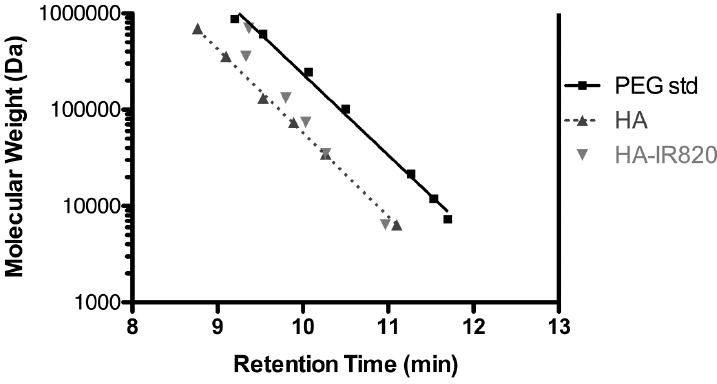
Figure 1. Retention time vs. MW for PEG standards, HA samples, and HA-IR820 conjugates from SEC, using a Shodex OHpak SB-806M HQ column, 5-mM acetate buffer (acetic acid/ammonium acetate) at pH 5 (0.8 mL/min flow rate) coupled with UV detection ( λ = 520 nm) and evaporative light scattering detection (ELSD, 70 